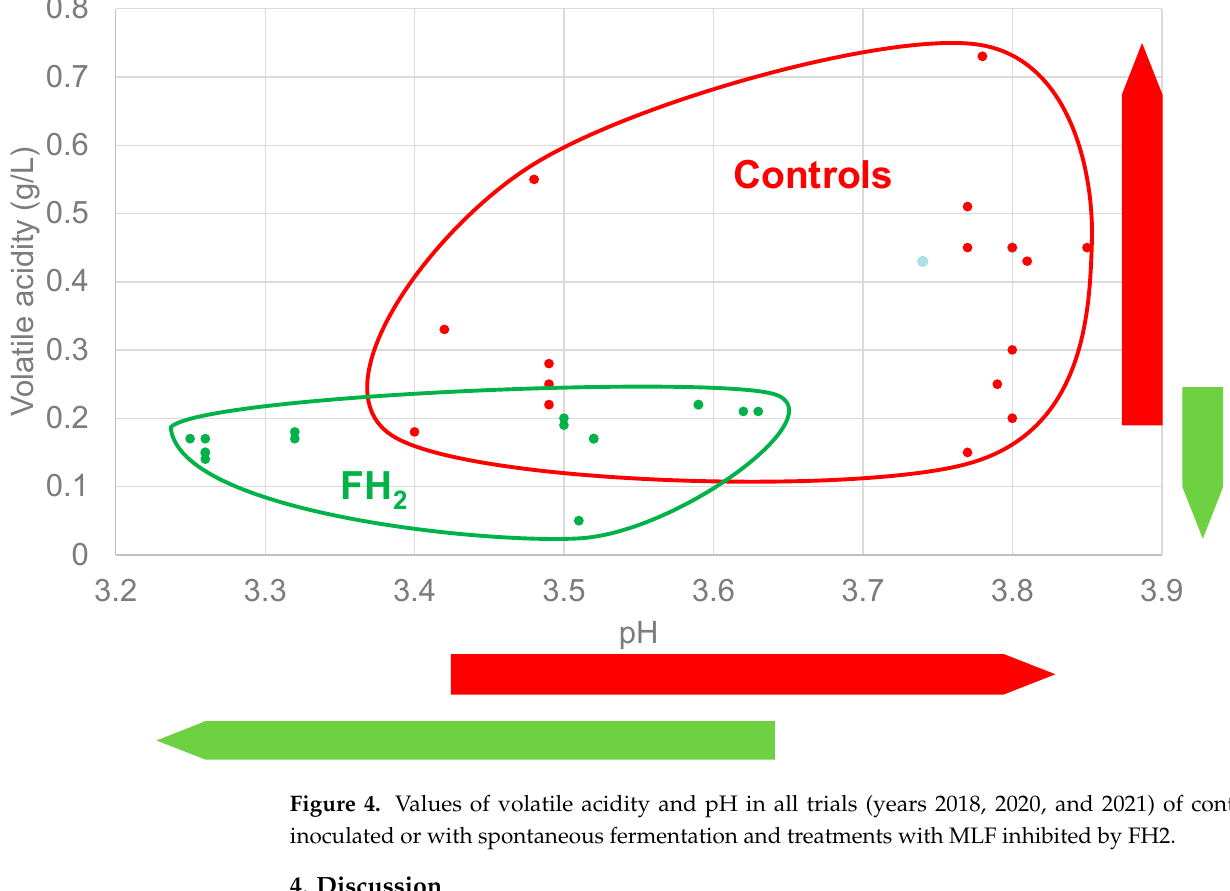
8 of 11 Figure 3. Evolution of malic acid (g/L) and volatile acidity (g/L) during spontaneous or inoculated (alpha, O. oeni ) MLFs with or without inhibition with FH2 (600 mg/L). Malic acid in control ( ), control with FA ( ), control with LAB ( ), and control with FA and LAB ( ). Volatile acidity in control ( ), control with FA ( ), control with LAB ( ), and control with FA and LAB ( ). Values are the means and bars are standard deviations of triplicate independent fermentations. Letters of last day represent significant differences. When the results of all trials were represented as function of pH and VA, all the fer- mentations inhibited by FH2 were observed to remain at values close or lower than 0.2